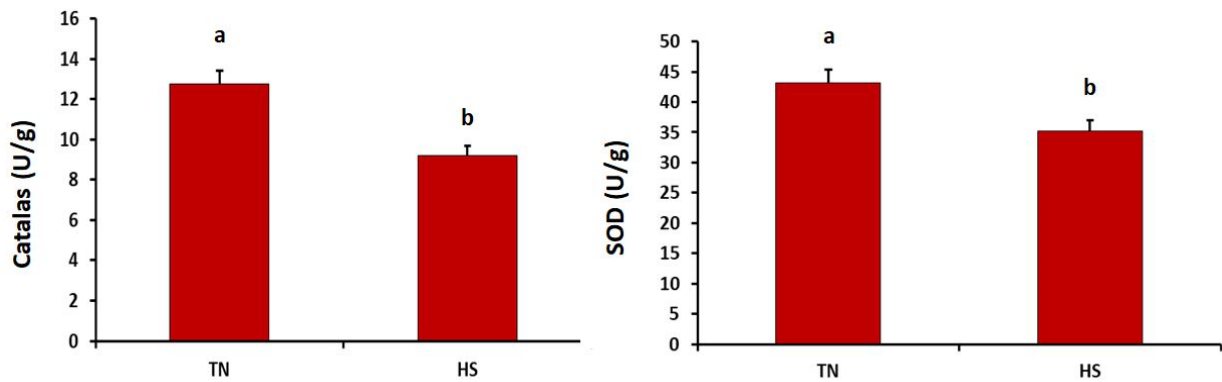
Figure 1. Effects of chronic heat stress on malondialdehyde (MDA) levels in breast ( A ) and thigh ( B ) muscles of broiler chickens ( p = 0.032 and 0.149, respectively). a,b Values with different superscripts differ significantly.